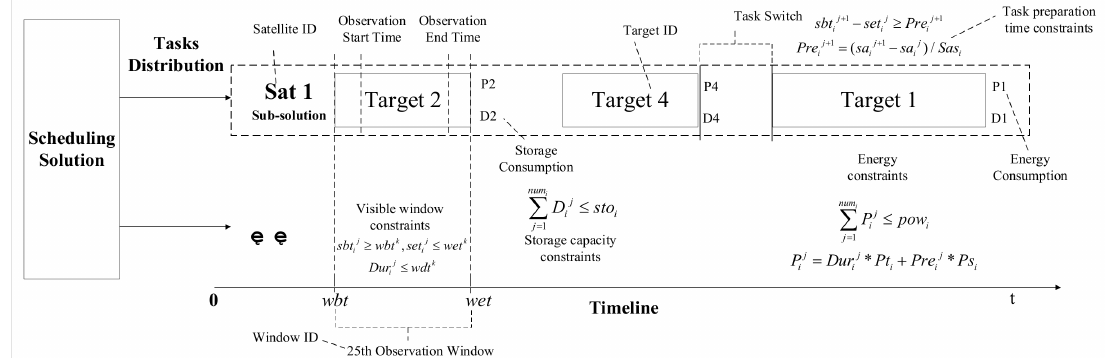
Figure 1. Scheduling